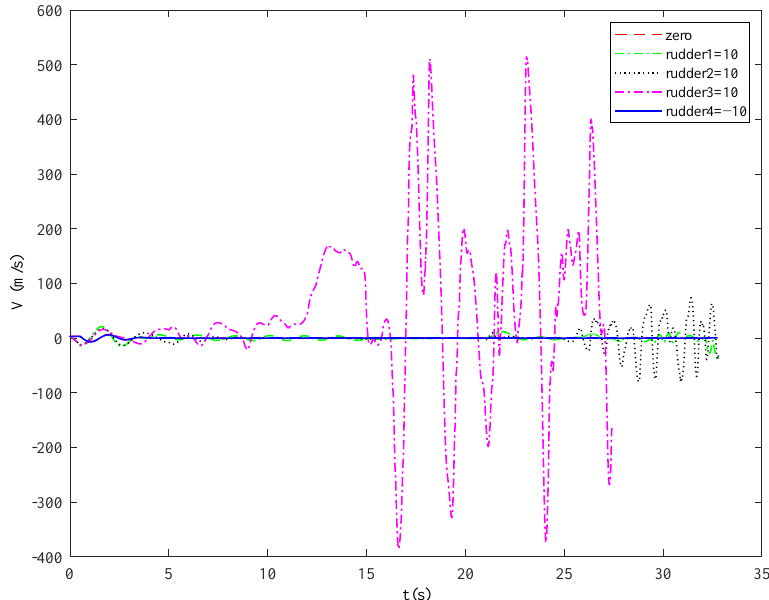
Figure 8. Change curve of roll angle rate in case of steering gear stuck.